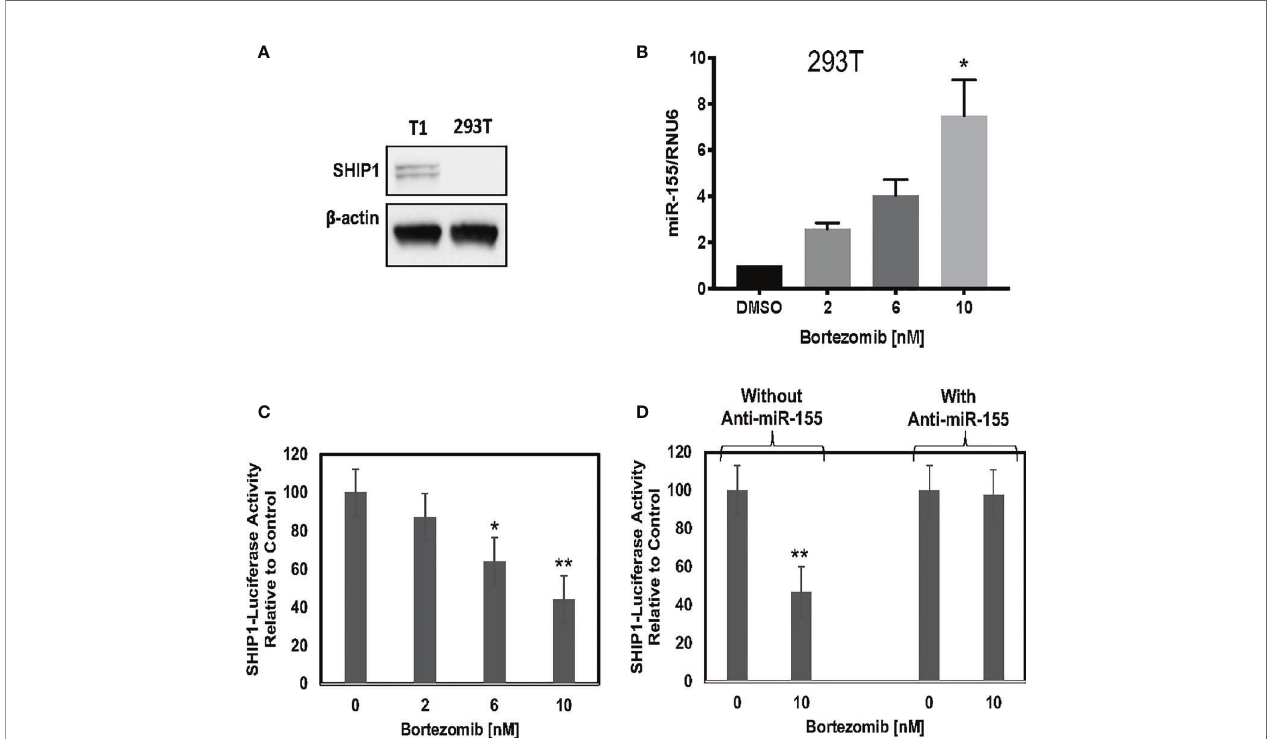
FIGURE 7 | Blockade of miR-155 expression abrogates bortezomib-mediated decrease in SH-2 containing inositol 5 ’ -polyphosphatase 1 (SHIP1) levels. Human HEK-293T cells were treated in vitro for 24 h with increasing concentrations of bortezomib (2, 4, 6, 8, 10 nM). The cells were collected and analyzed for miR-155 expression by RT-PCR and for SHIP1 protein level by Western blotting. (A) Western blot shows lack of SHIP1 expression in 293T cells in comparison with T1 cells. (B) The expression of miR-155 in 293T cells is shown upon bortezomib treatment at the indicated concentrations. 293T cells were transfected with 100 µg of SHIP1 3 ’ -UTR luciferase reporter plasmid and treated with increasing concentrations of bortezomib as indicated in combination with or without 200 pmoles of anti-miR-155. (C) Bortezomib ’ s dose dependent effect on SHIP1-luciferase reporter activity is shown in 293T cells. (D) Bortezomib ’ s effects on SHIP1-luciferase activity in 293T cells in the presence or absence of anti-miR-155 are shown. Data are mean values ± SD from three independent experiments with triplicates; * p < 0.0148 compared to DMSO, ** p < 0.0001 compared to DMSO or anti-miR-155 (ANOVA,